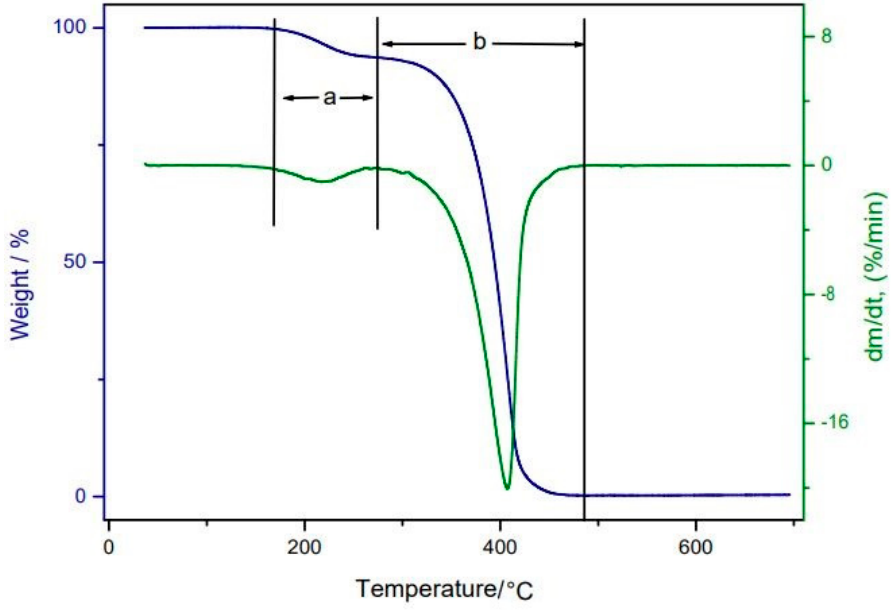
Figure 5. TG/DTG curves for buriti oil; a = first step; b = second step.